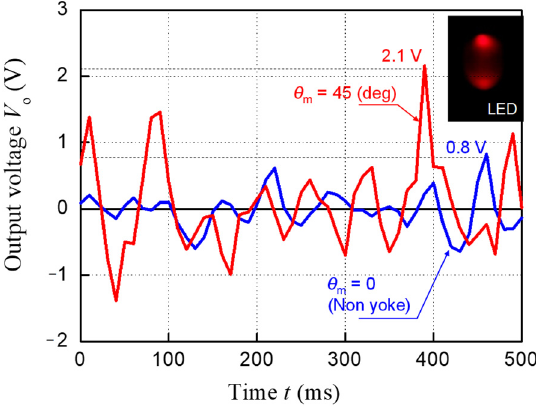
Figure 15. Output voltage of the bicycle motion experiment.